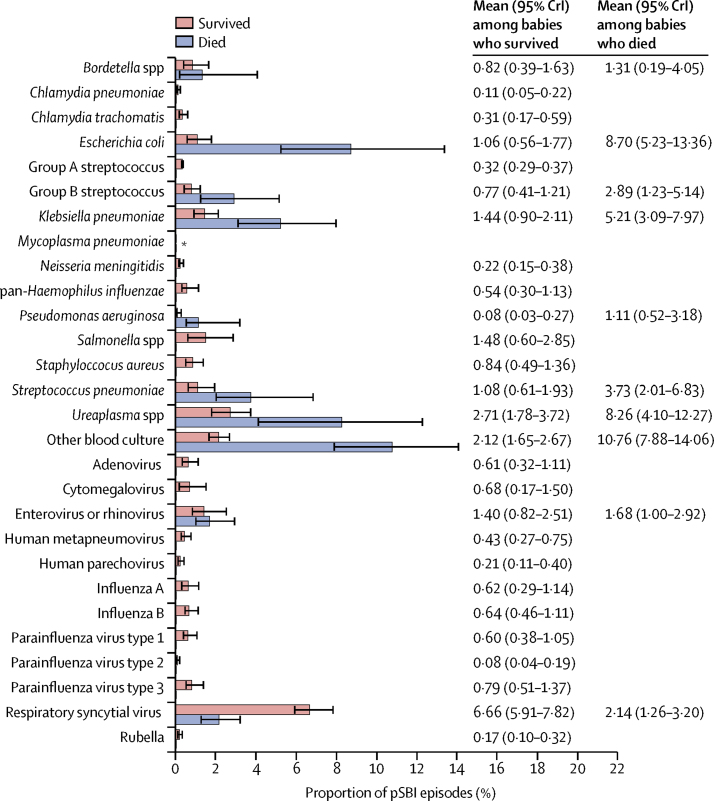
Attributed proportions of causal pathogens tested during possible serious bacterial infection episodes among babies who died and survived, estimated in a partially latent class modelCrI=credible interval. *None detected.